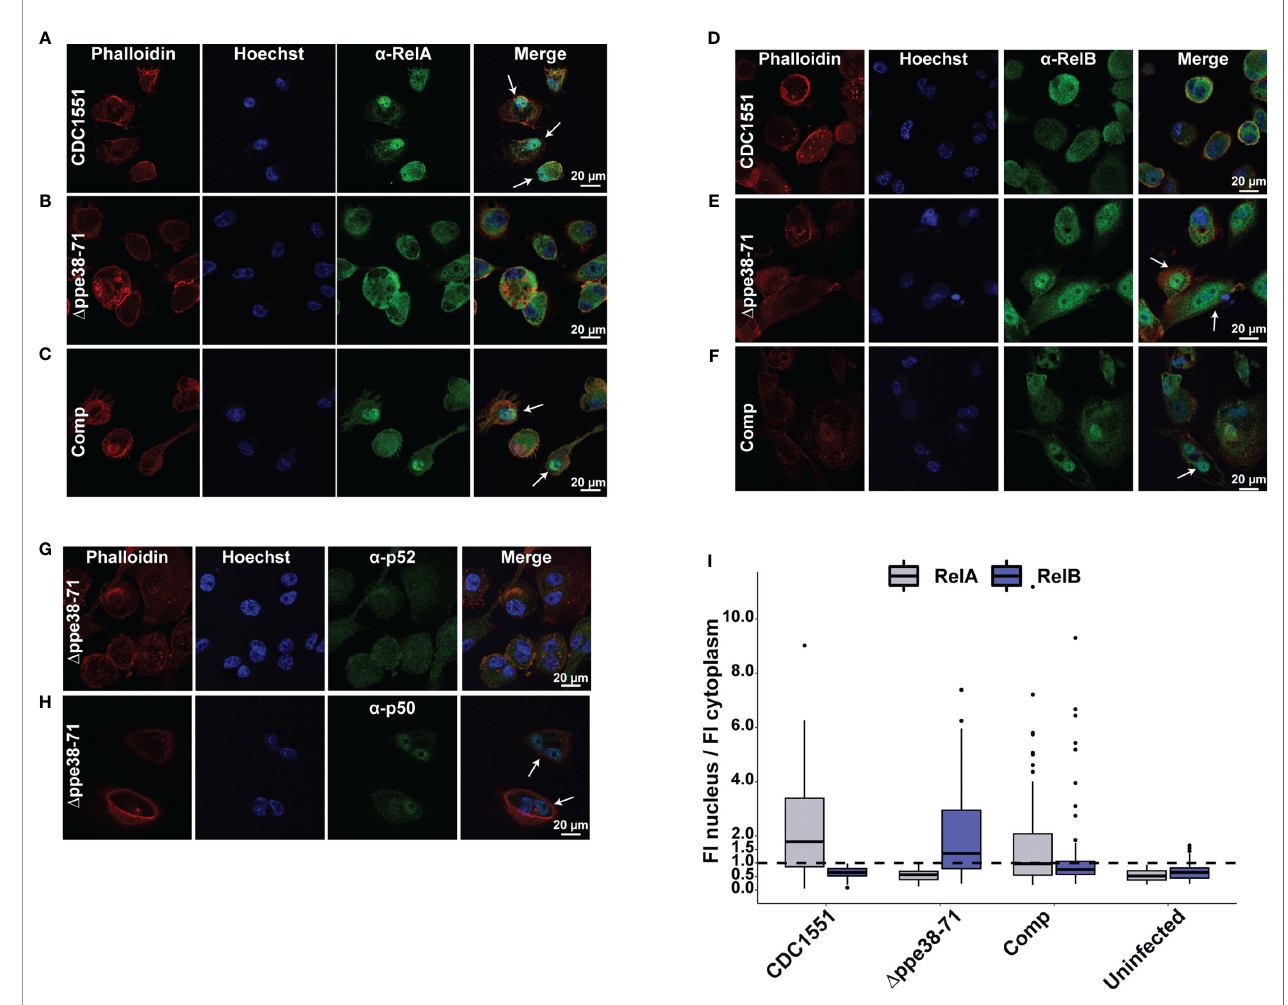
FIGURE 7 | Infection with M. tuberculosis D ppe38-71 stimulates a RelB/p50 pathway in THP-1 macrophage-like cells. Confocal microscopy images showing individual fl uorescent channels probing for F-actin (phalloidin), the nucleus (Hoechst) and (A – C) RelA (Alexa Fluor 488) for (A) M. tuberculosis CDC1551, (B) D ppe38- 71 , (C) complement-infected macrophages. Macrophages infected with (D) M. tuberculosis CDC1551, (E) D ppe38-71 and (F) the complemented strain were also probed for translocation of RelB (Alexa fl uor 488). (G) Confocal microscopy images showing p100/p52 and (H) p105/p50 nuclear translation in D ppe38-71 infected macrophages. White arrows indicate translocation events. (I) Quanti fi cation of fl uorescence intensity in the nucleus compared to that in the cytoplasm. Twenty cells were chosen from at least 10 random fi elds per replicate with a minimum of three independent experiments. The dashed line indicates a ratio of 1 for the cut off where translocation